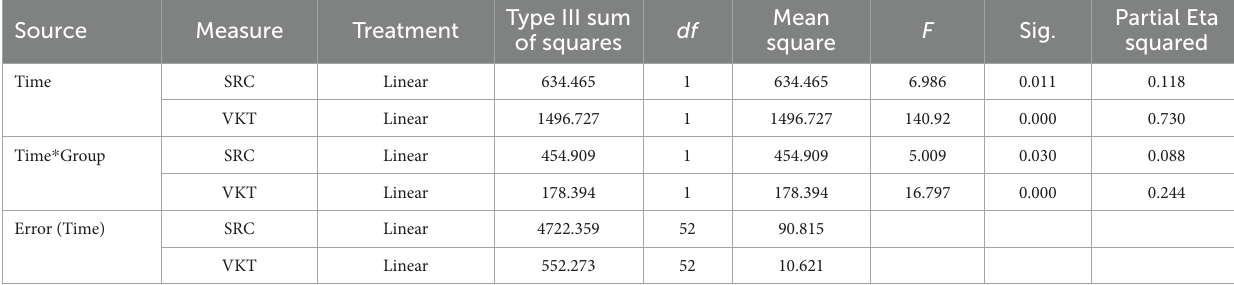
TABLE 2 Tests of within-subjects contrasts.